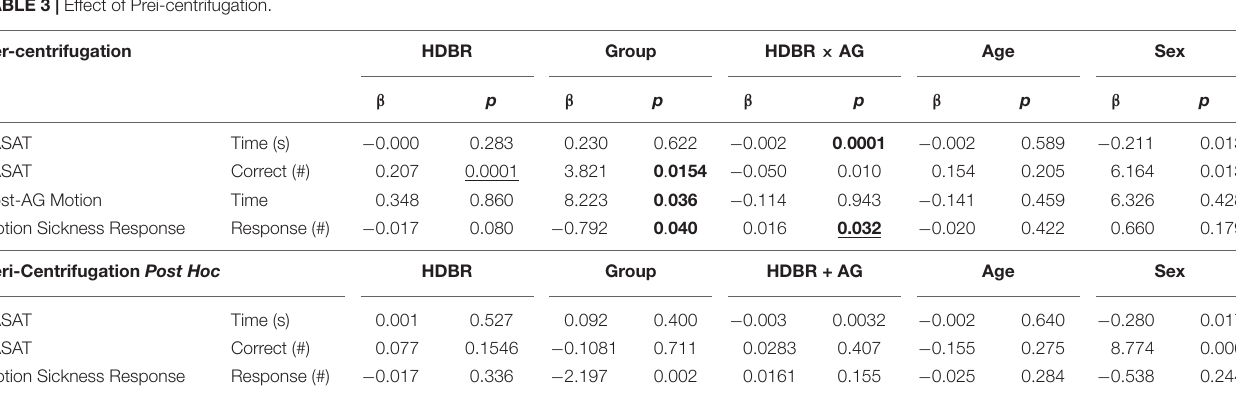
TABLE 3 | Effect of